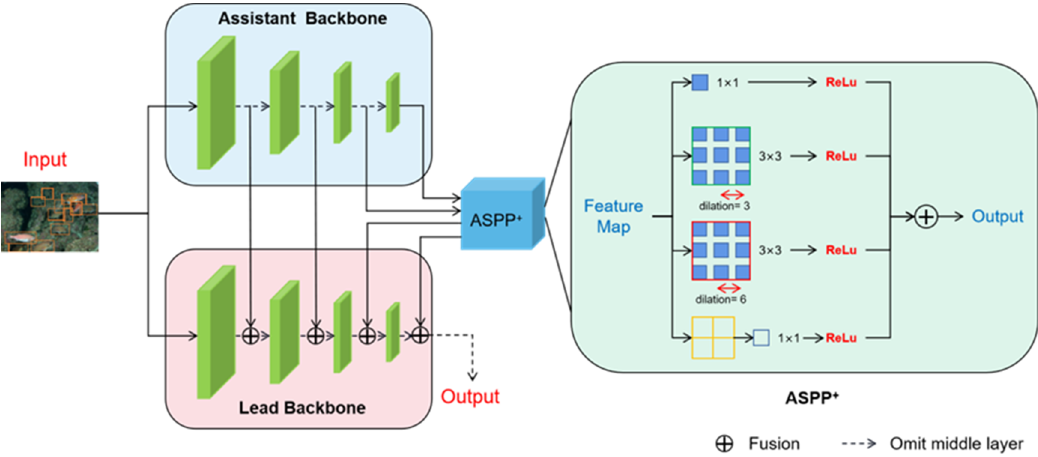
Figure 4. Structure diagram of the backbone network.